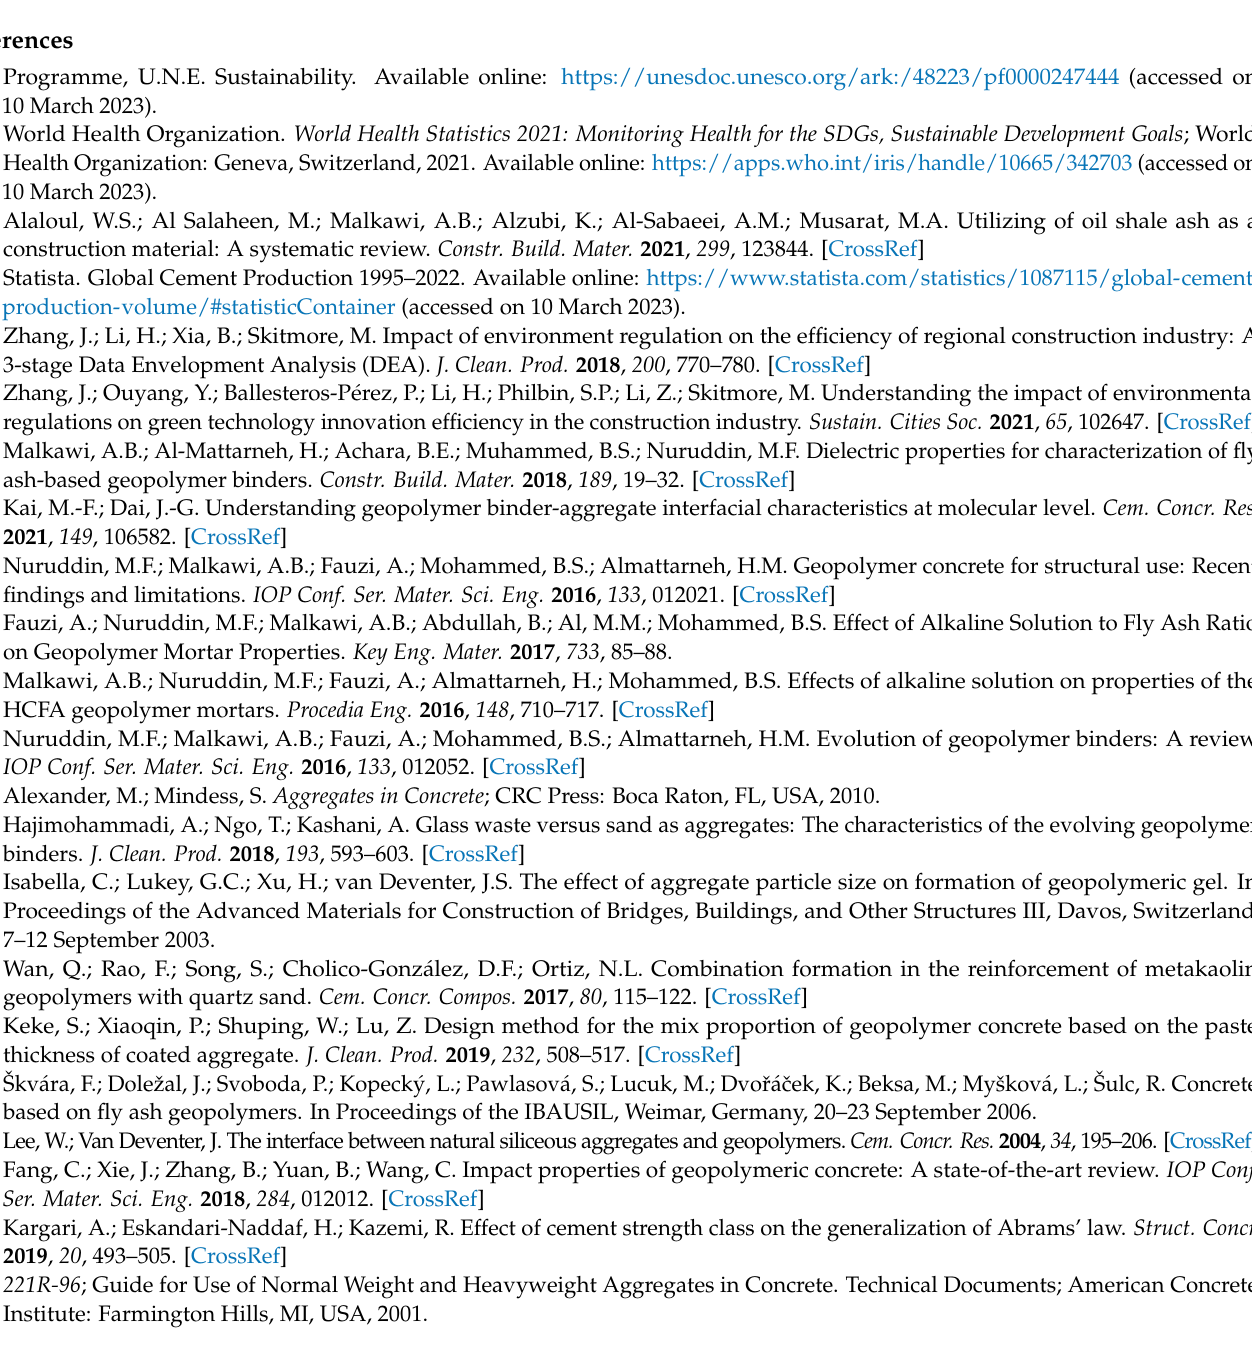
Figure A3. Perturbation plot of the slump, AVPP, and air content: A = AVF, B = CAR, C = MAS, and D = FFM.